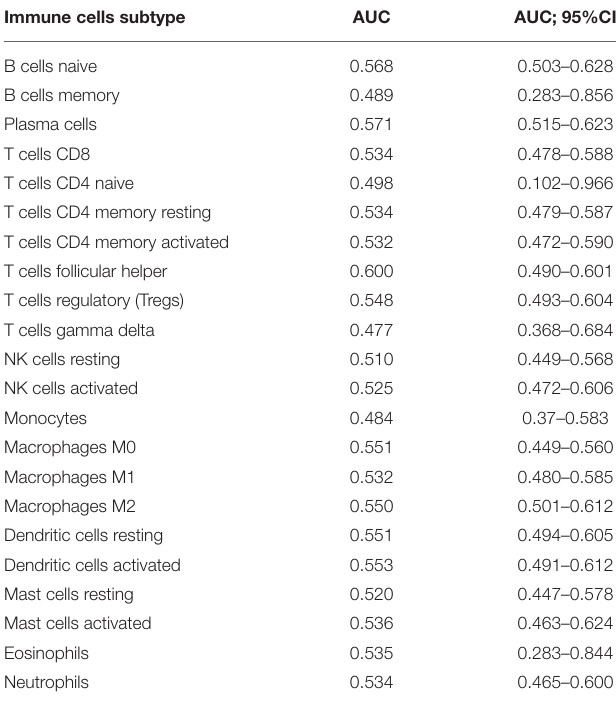
TABLE 3 | The AUC value for each immune cell. Immune cells